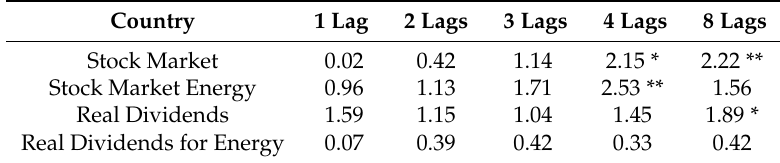
Table 2. Granger Causality tests: shadow interest